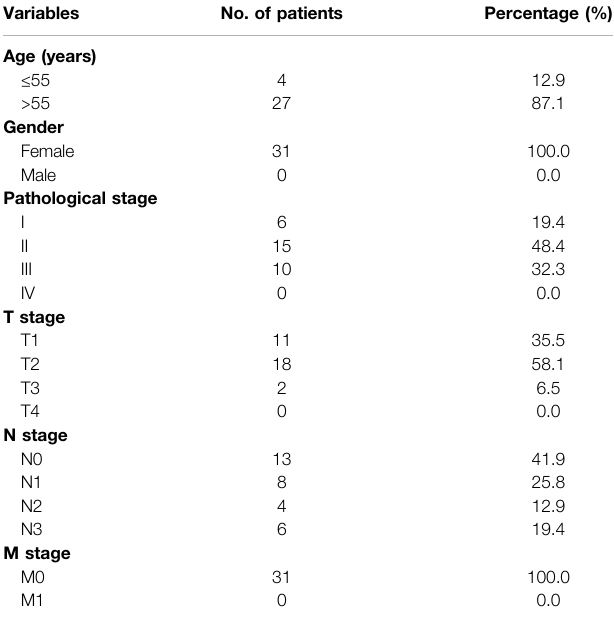
TABLE 2 | Clinical information of 31 patients with breast cancer in the qPCR